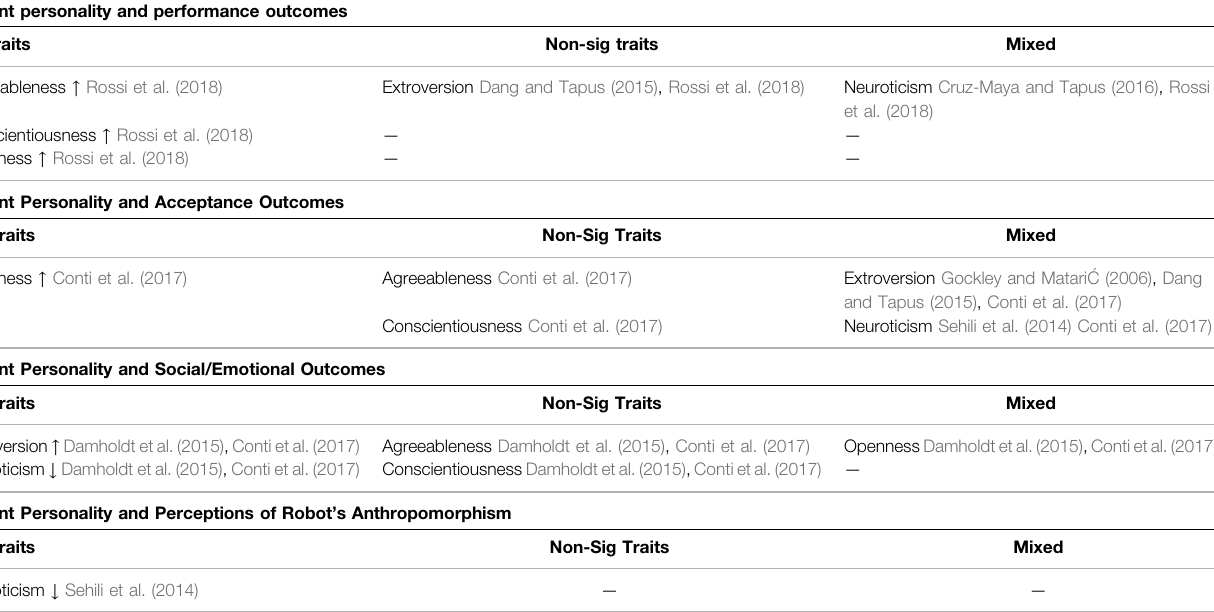
TABLE 6 | Patients personality traits impacts on outcomes by traits, where ↓ indicates a negative relationship and ↑ indicates a positive